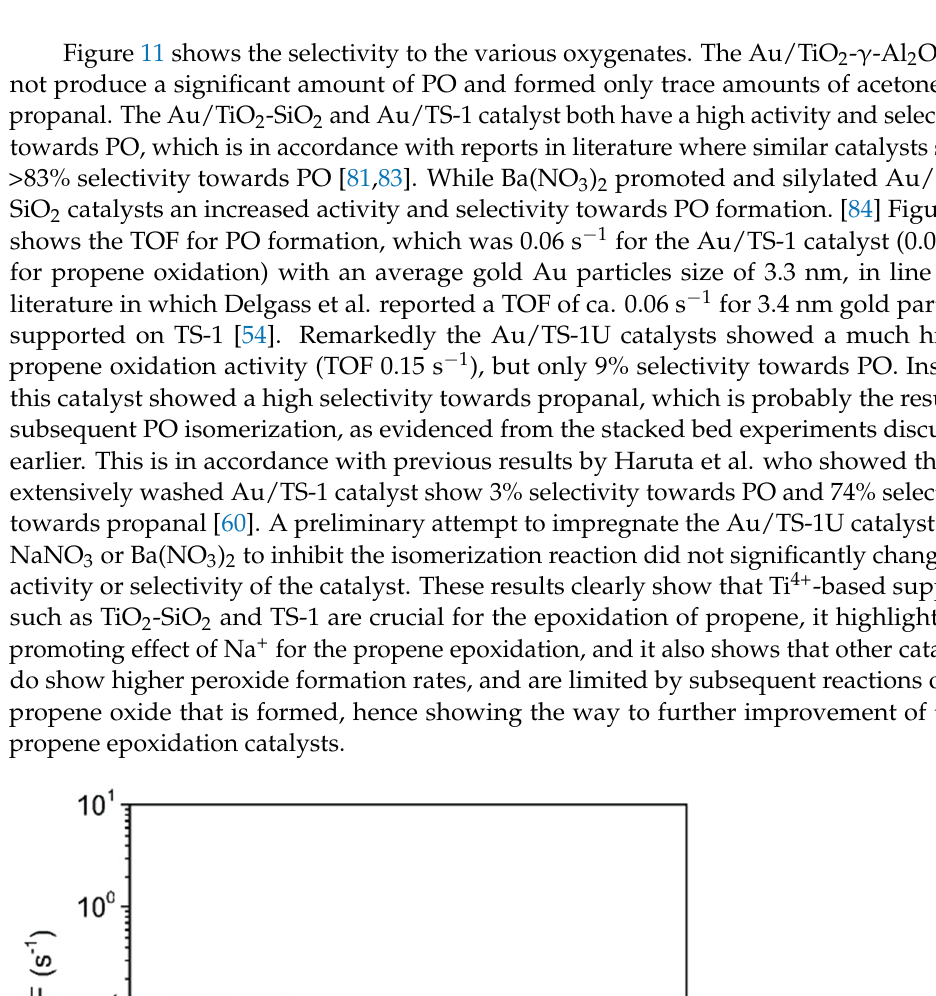
15 of 24 Figure 11. Carbon selectivity during the oxidation of propene over gold on Ti-modified supports. Conditions: 150 mg of catalyst, 10,000 mL/g cat /h flow of 10% of each C 3 H 6 , O 2 and H 2 in He at 200 °C. Figure 11 shows the selectivity to the various oxygenates. The Au/TiO 2 - γ -Al 2 O 3 did not produce a significant amount of PO and formed only trace amounts of acetone and propanal. The Au/TiO 2 -SiO 2 and Au/TS-1 catalyst both have a high activity and selectivity towards PO, which is in accordance with reports in literature where similar catalysts show >83% selectivity towards PO [81,83]. While Ba(NO 3 ) 2 promoted and silylated Au/TiO 2 - SiO 2 catalysts an increased activity and selectivity towards PO formation. [84] Figure 12 shows the TOF for PO formation, which was 0.06 s − 1 for the Au/TS-1 catalyst (0.07 s − 1 for